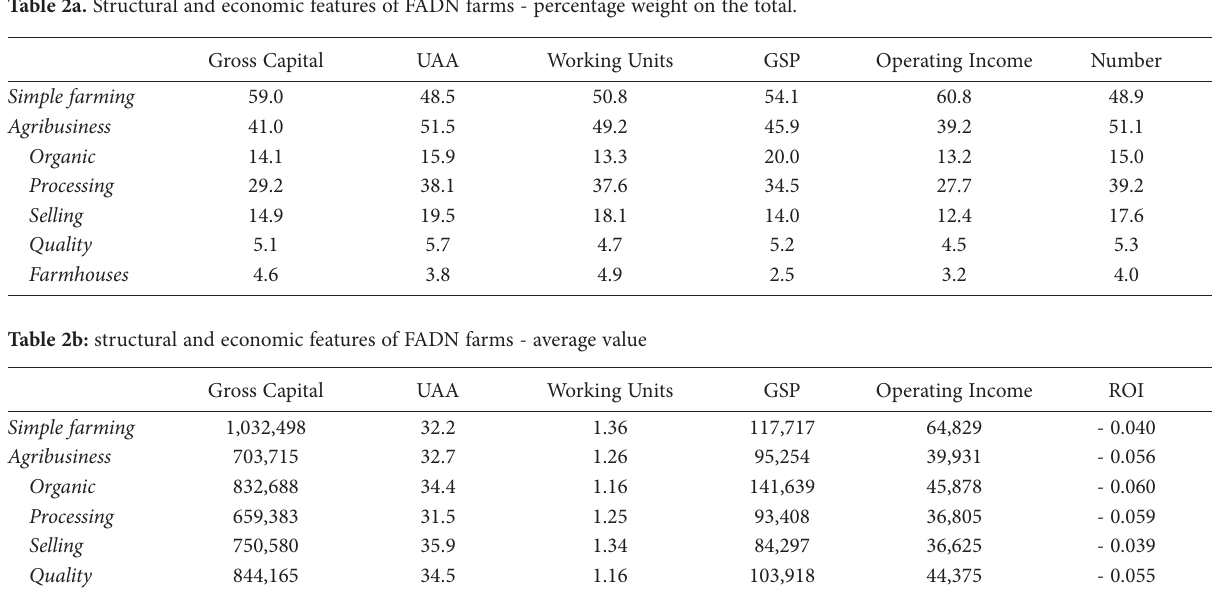
Table 2a. Structural and economic features of FADN farms - percentage weight on the total. Gross Capital UAA